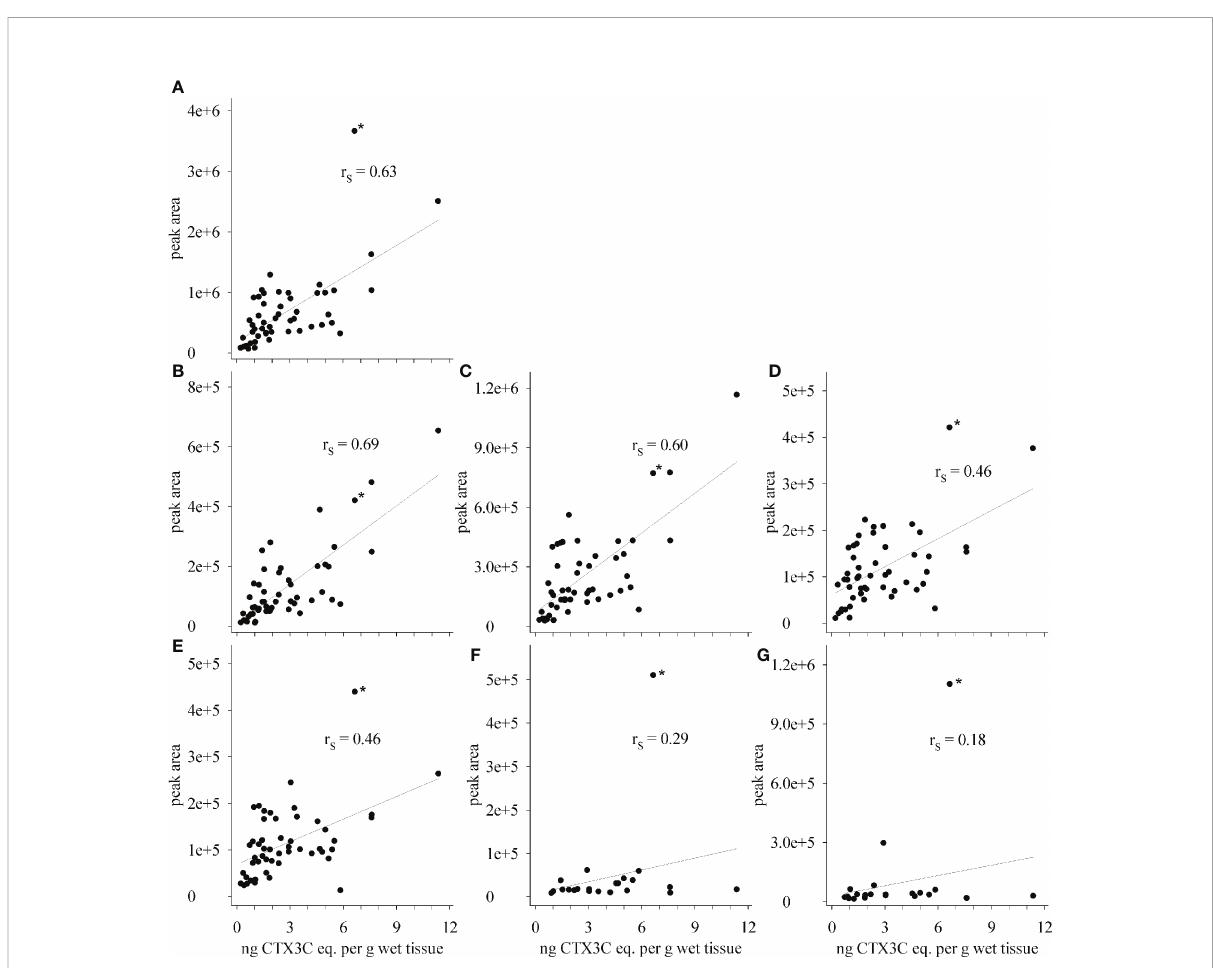
FIGURE 6 Correlation between composite toxicity determined by N2a-bioassay and peak areas determined by LC-MS/MS for (A) total peak area, (B) 2,3,51-trihydroxyCTX3C, (C) 2,3-dihydroxyCTX3C and 49-epimer, (D) M- seco -CTX3C and 49-epimer, (E) 2-hydroxyCTX3C and 49-epimer, (F) 51-hydroxyCTX3C, and (G) CTX3C and 49-epimer; r S - Spearman ’ s rank order coef fi cient; * - sample